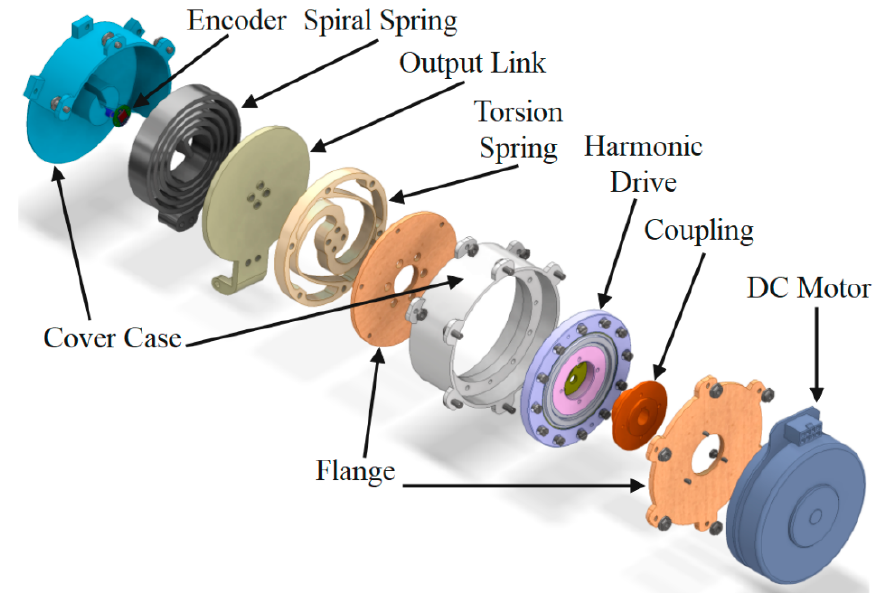
Figure 5. Assembly parts of ES ‐ RSEA.